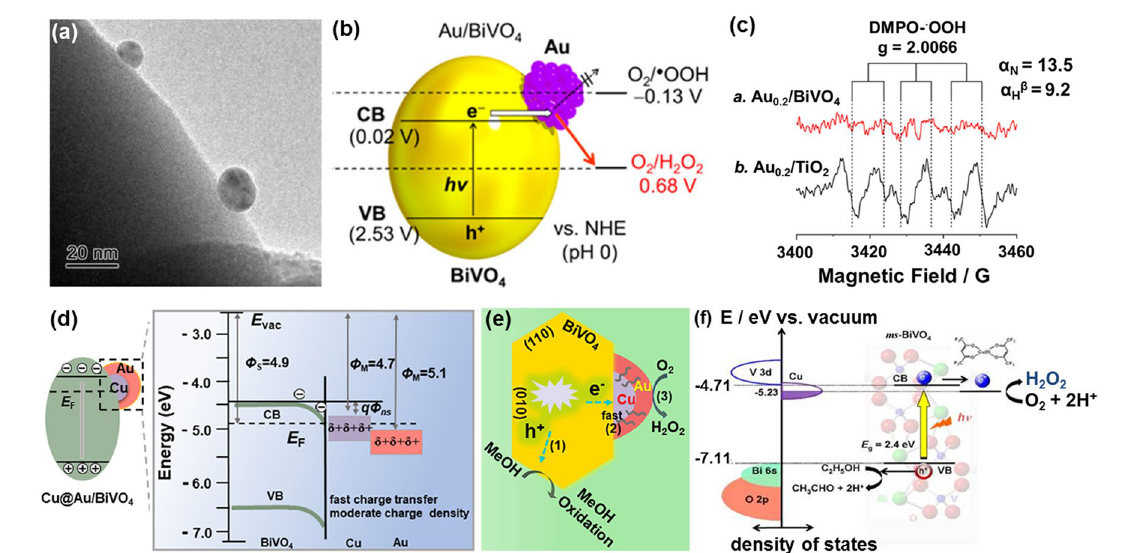
Fig. 9 a TEM image of an Au 0.2 /BiVO 4 photocatalyst. b Energy diagram of the Au/BiVO 4 photocatalyst and reduction potential of O 2 . c ESR spectra of an Au 0.2 /BiVO 4 photocatalyst and an Au 0.2 /TiO 2 photocatalyst in an EtOH/water/O 2 system with DMPO. Reproduced with permission from Ref. [163]. Copyright 2016 American Chemical Society. d Energy diagram of a Cu@Au/BiVO 4 photocatalyst. e Mechanism of H 2 O 2 gen- eration on a Cu@Au/BiVO 4 photocatalyst. Reproduced with permission from Ref. [166]. Copyright 2021 American Chemical Society. f Energy diagram and the reaction mechanism of a Cu(hfacac) 2 /ms-BiVO 4 photocatalyst. Reproduced with permission from Ref. [167]. Copyright 2020 American Chemical